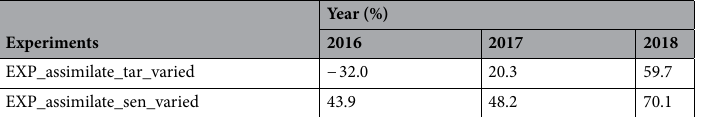
Table 1. Assessment of the designed observing strategy in the hindcast years of 2016–2018 (RMSEs improvement in percentage).